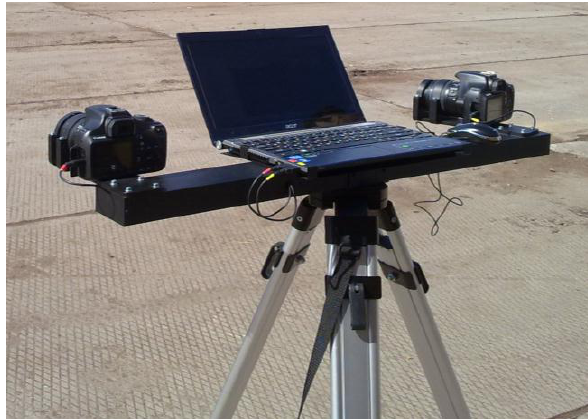
Figure 2. Portable photogrammetric system For automated reference points detection and identification and their sub-pixel image coordinates measuring the original coded target are used (Knyaz V.,2002 ).